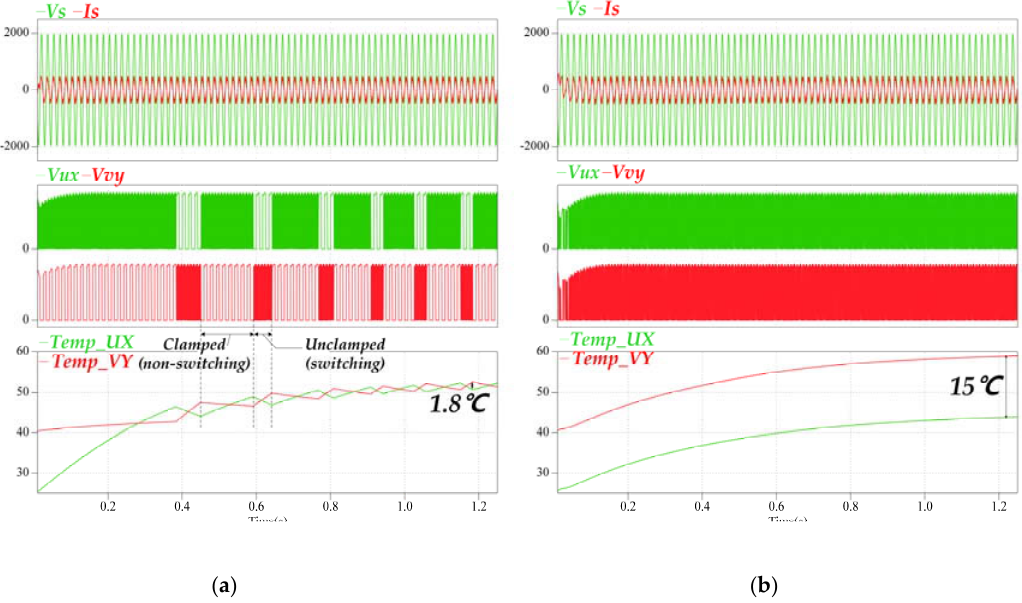
Figure 11. Comparison of temperature variation reduction ability between ( a ) proposed DPWM and ( b ) conventional CB ‐ SPWM (from top, Vs , Is ; Vux , Vvy ; Temp_UX , Temp_VY